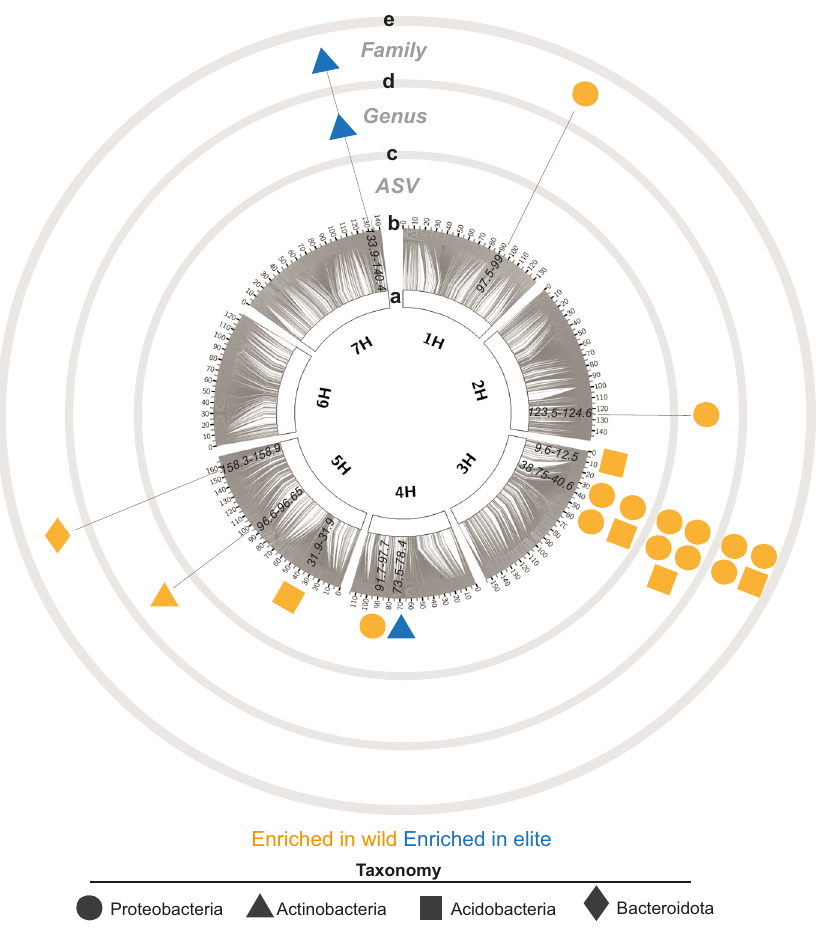
Fig. 2 Genetic map of the barley determinants of individual bacterial members of the rhizosphere microbiota. Circos plot depicting a the seven barley chromosomes and b grey connector lines link the physical position of SNPs with the genetic position in cM as indicated in the outer part of the ring; numbers in black within the individual chromosome de fi ne genetic positions (cM) signi fi cantly associated (using the function scanone implementing interval mapping with a single-QTL model, expectation-maximization algorithm, LOD genome-wide signi fi cance threshold 20% adjusted per taxa, 1000 permutations) to the differential enrichment of individual c ASVs, d genus or e family, respectively. Different shapes depict taxonomic assignment at phylum level. Shapes are colour-coded according to the microbiota of the parental line where individual taxa were identi fi ed. Source data are provided as a Source data fi